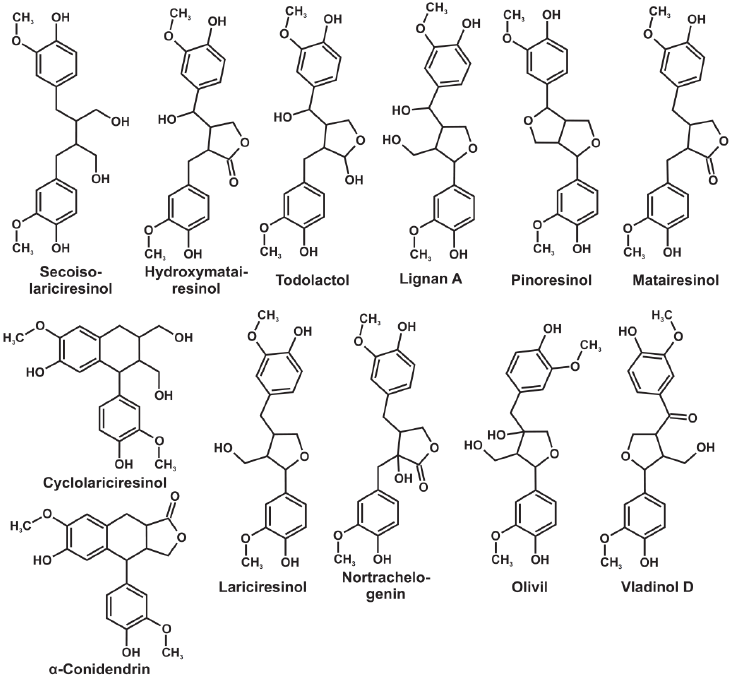
Figure 3. Structural formulas of the lignans identified in coniferous knotwood extracts.